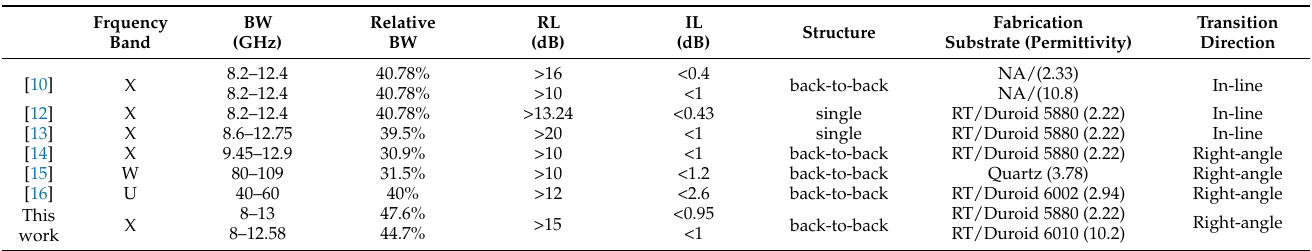
Table 3. Comparison of waveguide-to-CPW